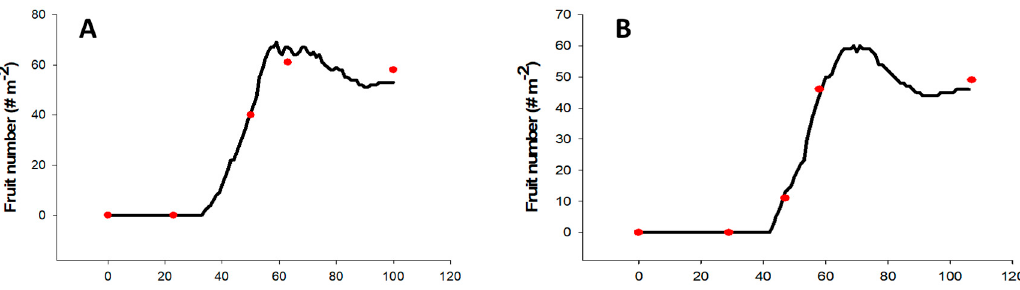
Figure 3. Results of the model calibration for fruit number during the fall 2016 ( A ) and spring 2017 ( B ) seasons and yield during the fall 2016 ( C ) and spring 2017 ( D ) seasons of drip ‐ irrigated fresh ‐ market tomato production in Immokalee, Florida.